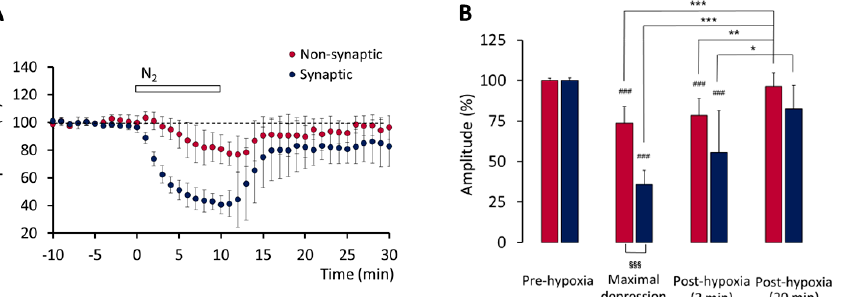
Figure 1. Hypoxia-induced changes on fEPSPs recorded in layers II/III of the primary motor cortex, in brain slices from infant rats. ( A ) Time course of the effect of hypoxia on the amplitude of non-synaptic (red symbols) and synaptic (blue symbols) components of the fEPSPs ( n = 5). ( B ) Amplitude of non-synaptic (red histograms) and synaptic (blue histograms) components of the fEPSPs: comparison of the mean values ( ± SD) recorded during 10 min before hypoxia onset (pre-hypoxia), during the minute corresponding to the maximal hypoxia-induced depressive effect, and during min 3 and min 20 after re-oxygenation onset. ### p < 0.001, *** p < 0.001, ** p < 0.01, * p < 0.05; §§§ p < 0.001 (vs. the columns